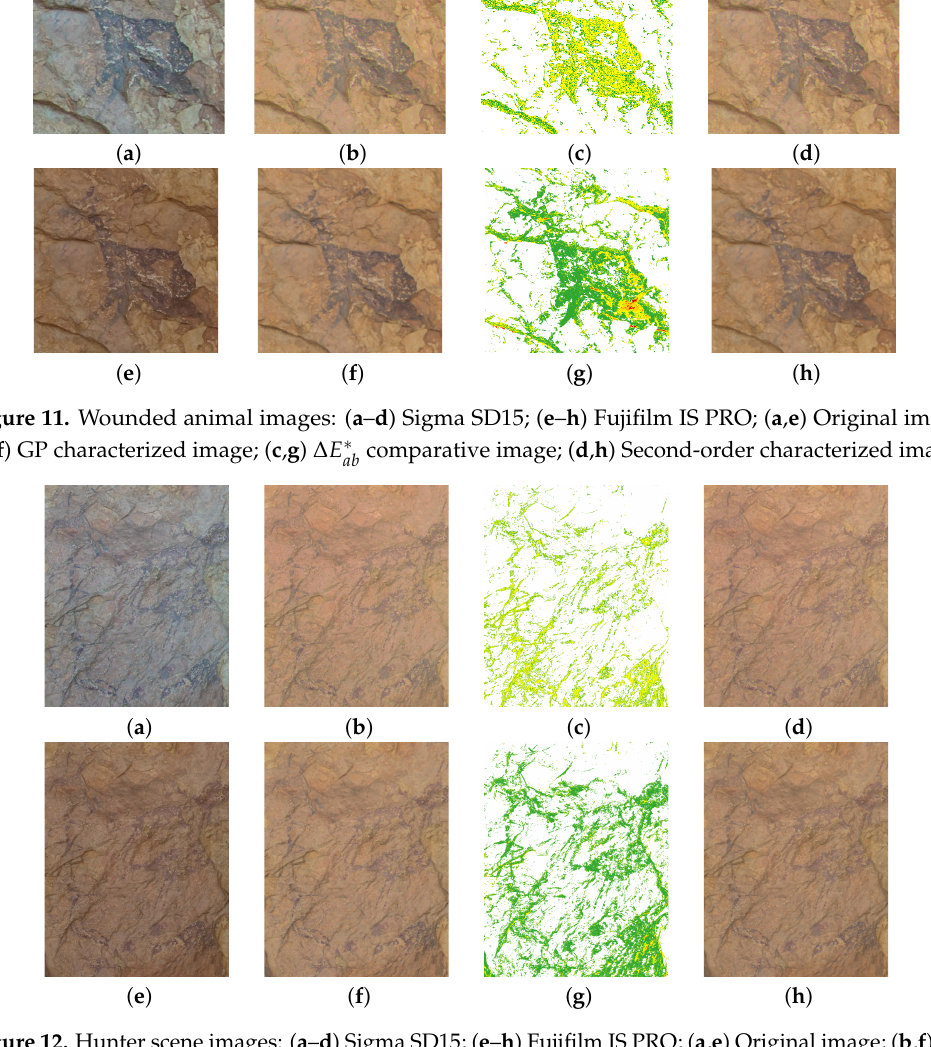
Figure 12. Hunter scene images: ( a – d ) Sigma SD15; ( e – h ) Fujifilm IS PRO; ( a , e ) Original image; ( b , f ) GP characterized image; ( c , g ) ∆ E ∗ comparative image; ( d , h ) Second-order characterized ab